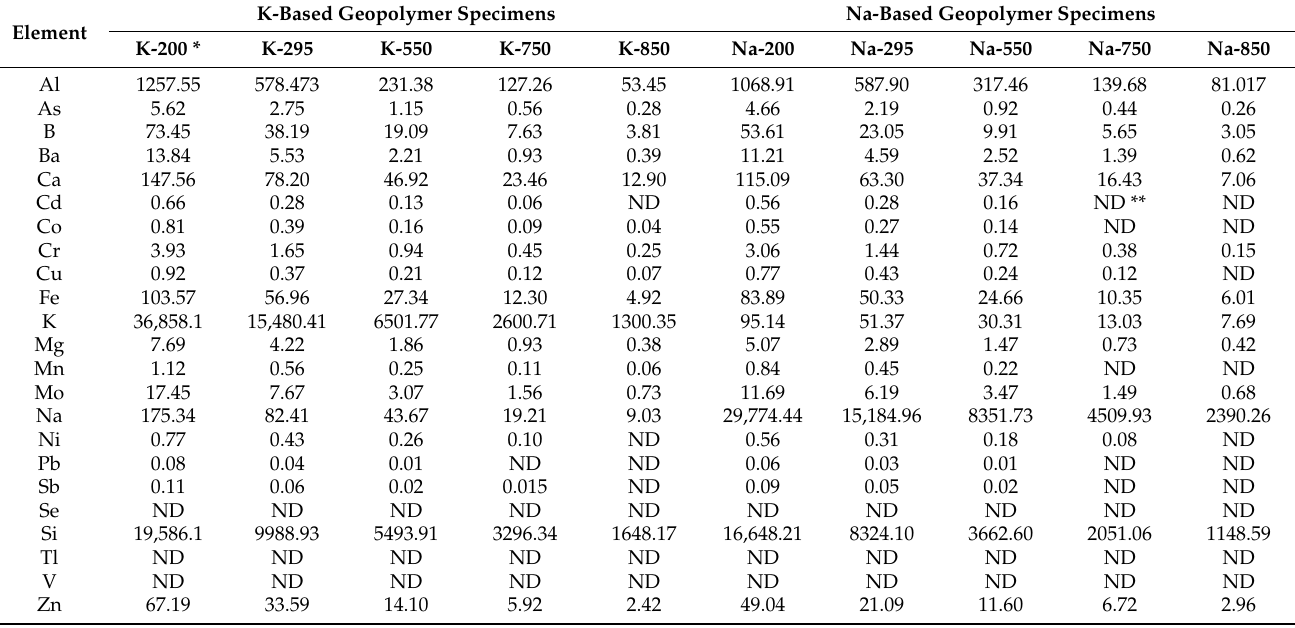
Table 11. The cumulative concentrations of the released heavy metals and trace elements from the surfaces of the geopolymer specimens (mg/m 2 ).